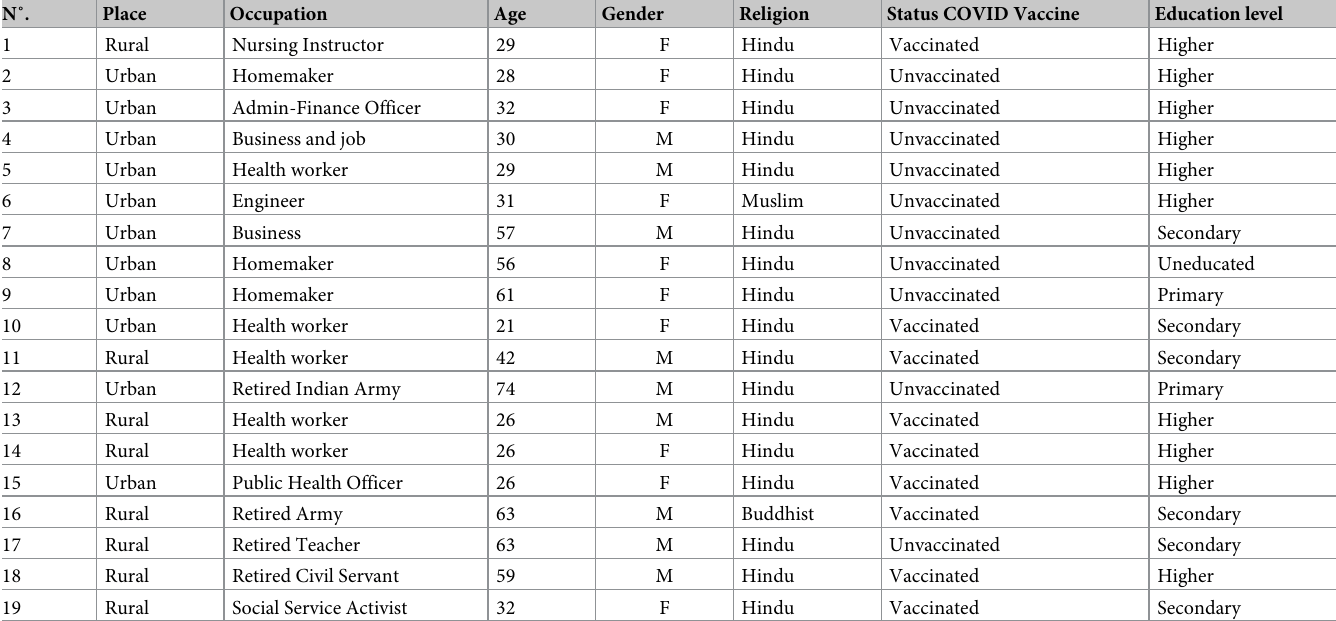
Table 1. Socio-demographics of participants in the